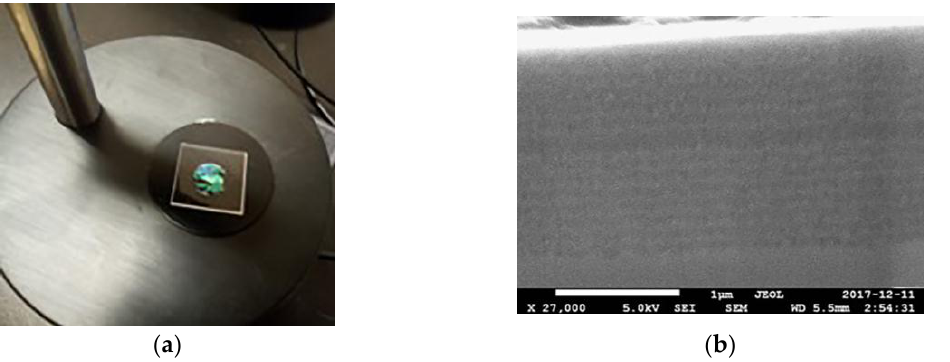
Figure 1. These figures show the membrane of a microcavity on a quartz substrate and an SEM measurement of a microcavity deposited on 𝑝 + silicon substrate. ( a ) The membrane of a microcavity on a quartz substrate that is used for the sensing measurements; and ( b ) Cross-section SEM of a microcavity on 𝑝 + silicon substrate with 31 layers. The existence of a microcavity and the contrast between both of the refractive indexes are shown. The membrane has an area of 1 cm 2 .